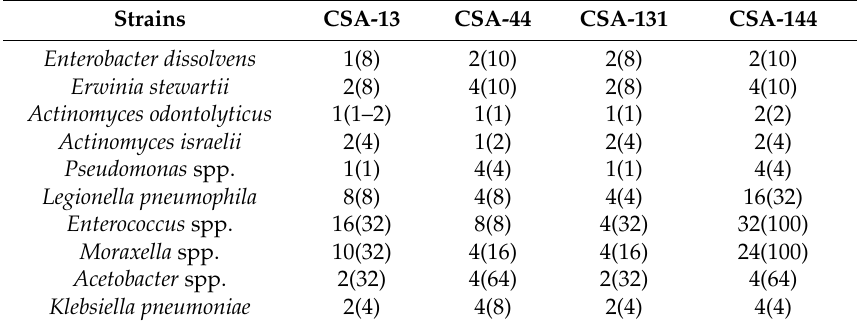
Table 3. Comparison of the MIC (minimum bactericidal concentrations (MBC)) ( µ g/mL) of ten isolates to selected ceragenins.